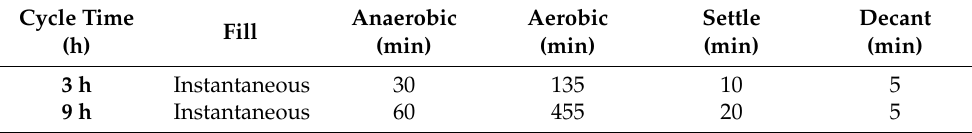
Table 1. Operational cycle for